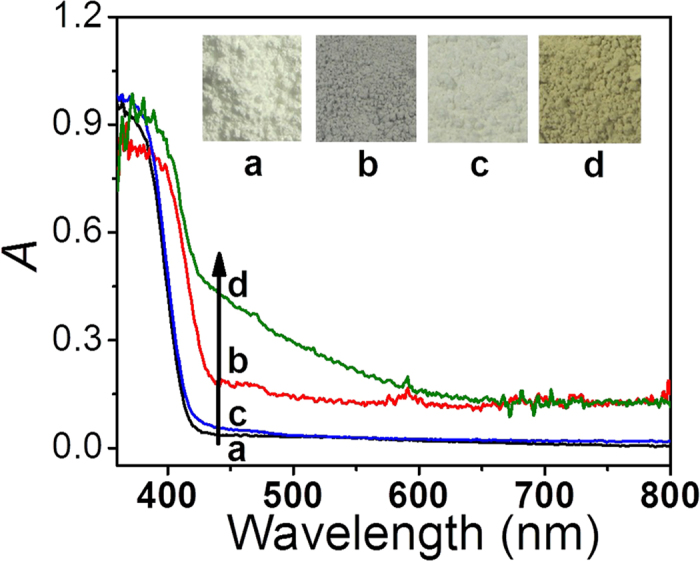
UV-vis spectra and the corresponding photographs (inset):(a) TiO2; (b) rGO-TiO2; (c) Fe(III)/TiO2; (d) Fe(III)/rGO-TiO2.